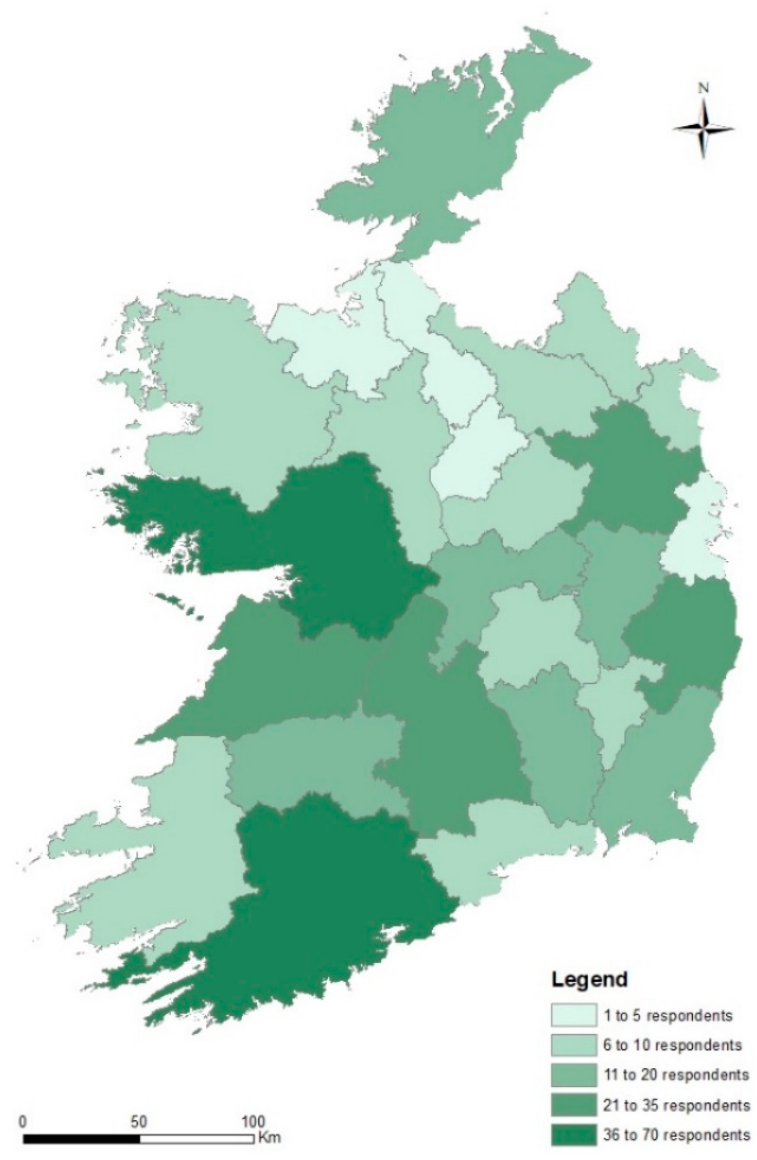
Figure 1. Survey responses by administrative county in the Republic of Ireland. Used with permission from Andrade et al. (2019). Table 3. Gender-related differences within RANAS components derived from ANOVAs and quantified by Hedges’ d .